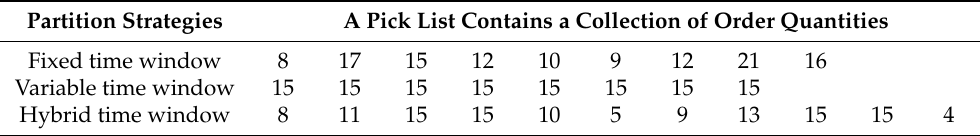
Table 3. A pick list contains a collection of order quantities.